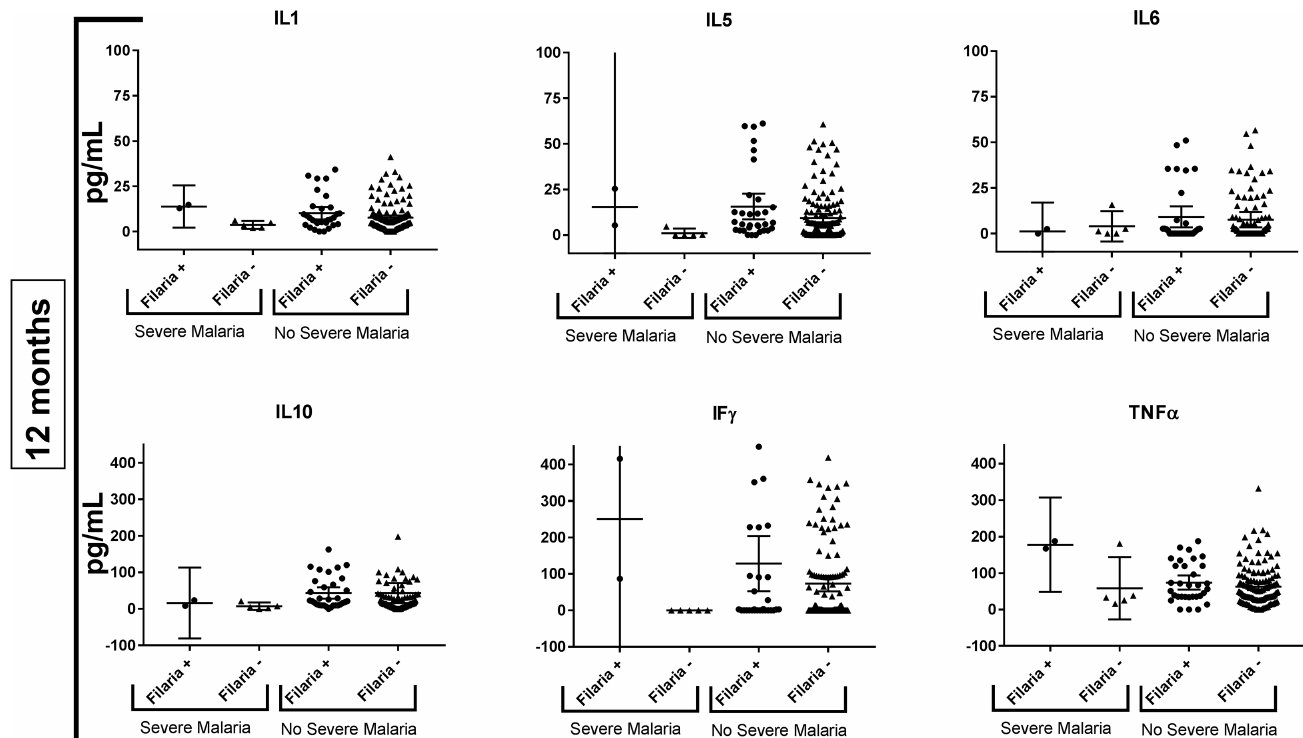
Fig 6. Cytokine profiles of children in the study at 12 months by filarial serostatus, stratified by whether they experienced (“Severe Malaria”) or did not experience (“No Severe Malaria”) severe malaria between 12 and 18 months of age.